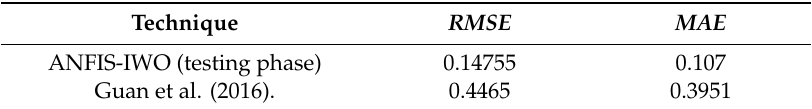
Table 5. Comparison between the prediction performance achieved by the best predictive model in the present study and empirical formulas proposed by Guan et al.